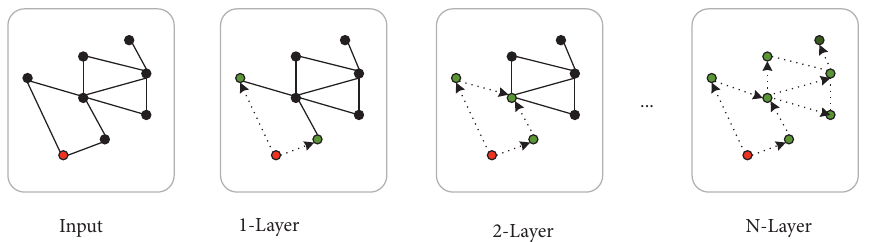
Figure 3: The process of capturing the spatial correlation of passenger flows using GCNs (taking red station as an